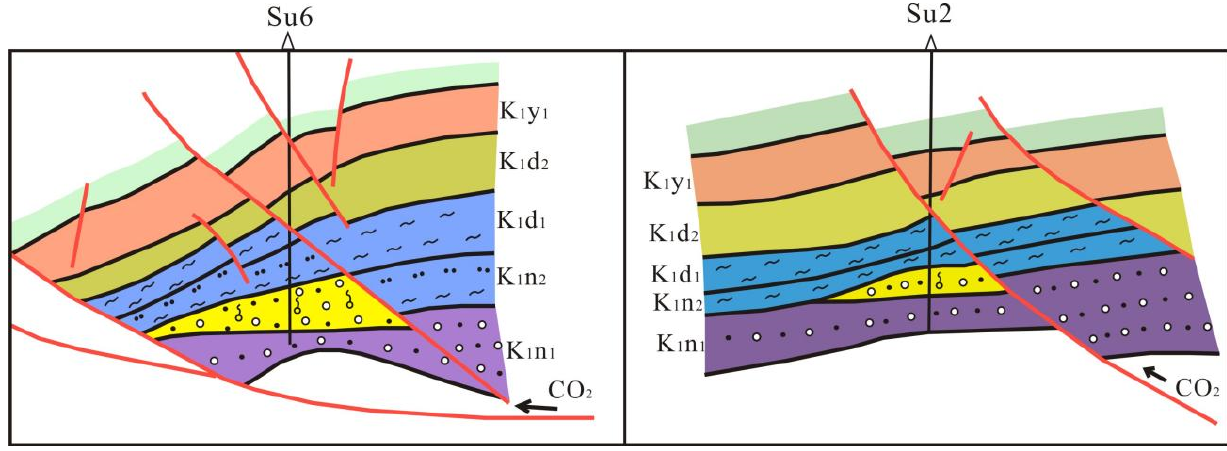
Figure 6. Relationship between CO 2 reservoir and deep faults in Wuerxun depression of Hailar Ba- sin.